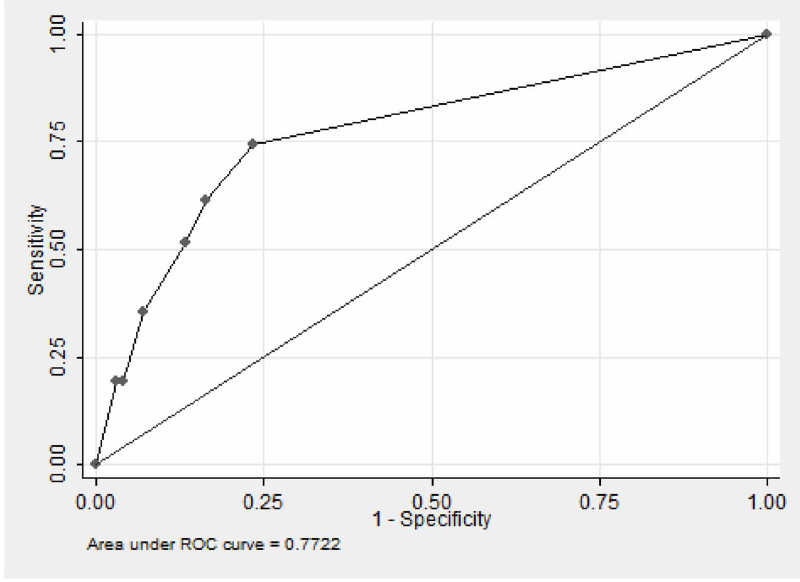
Figure 1. ROC curve of predictive logistic regression model for depression according to the scores of the PHQ – 2.